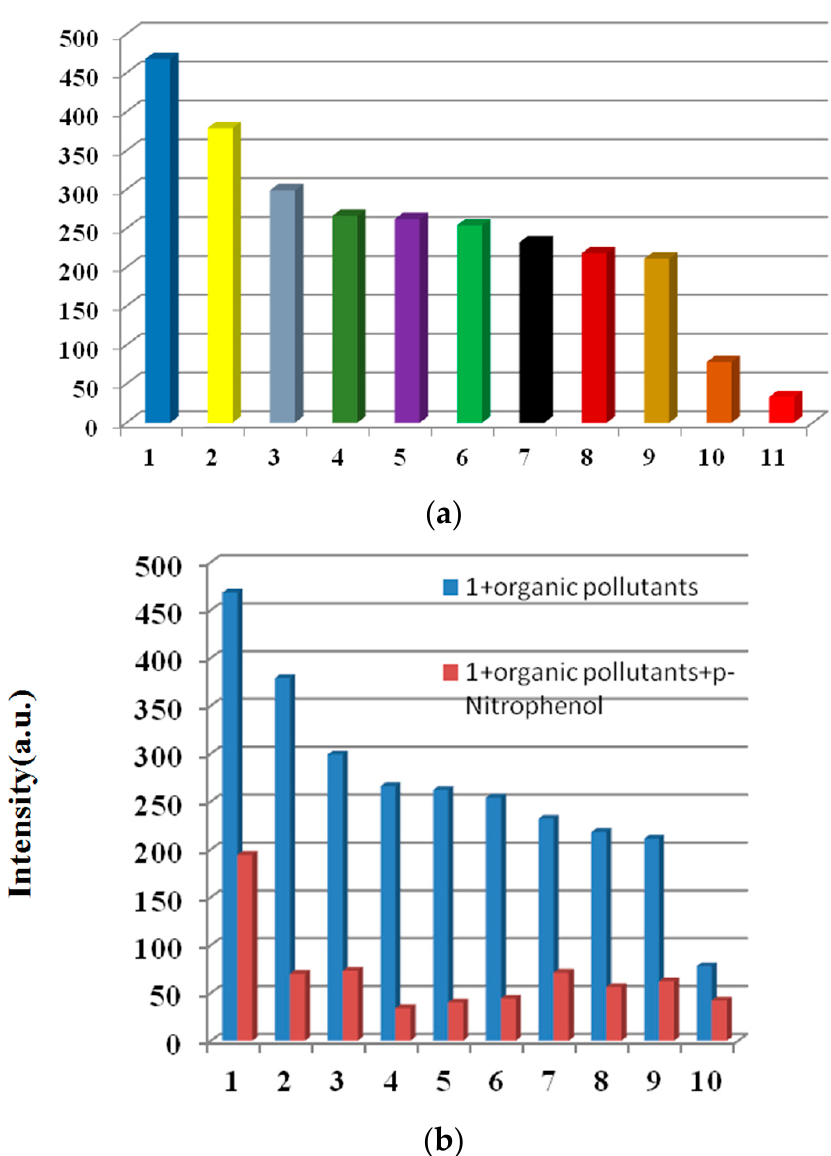
Figure 6. Luminescence intensity map of ( a ) complex 1 (1.5 mg) dispersed in aqueous solutions of multifarious organic pollutants (3 mL, 10 − 3 M) under the excitation of 275 nm and ( b ) with subsequent addition of p -nitrophenol. (1) 4-aminophenol, (2) 2,4,6-Trichlorophenol, (3) o -aminophenol, (4) 2,4-dichlorophenol, (5) phenol, (6) carbaryl, (7) p -chlorophenol, (8) m -dihydroxybenzene, (9) atrazine, (10) 2,6-dichloro-4-nitroaniline, and (11) p -nitrophenol.